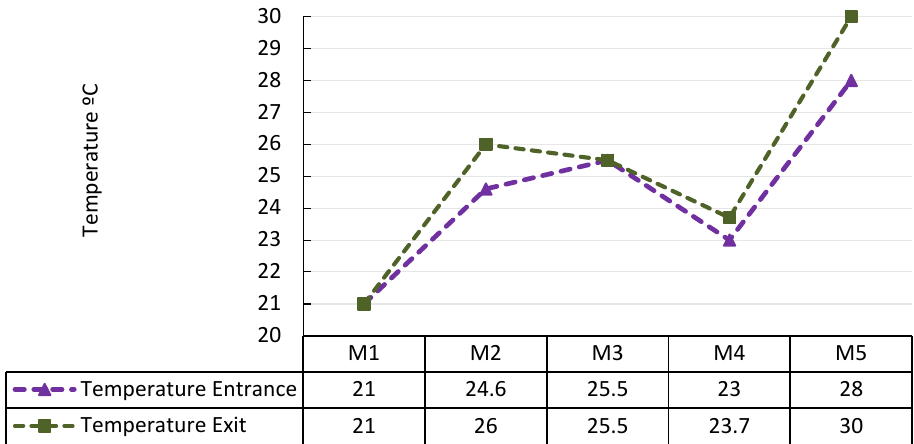
Fig. 4: Temperature of the treated and untreated effluents in the 5 samplings